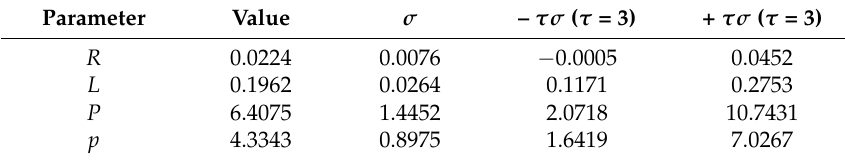
Table 3. Results from the analysis of the vertical displacement of point A5.